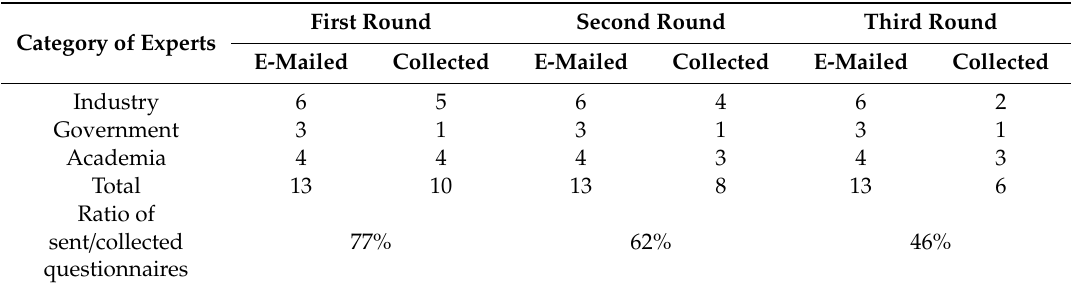
Table 3. Ratios of sent / collected questionnaires on the importance of the criteria and sub-criteria. First Round Category of Experts